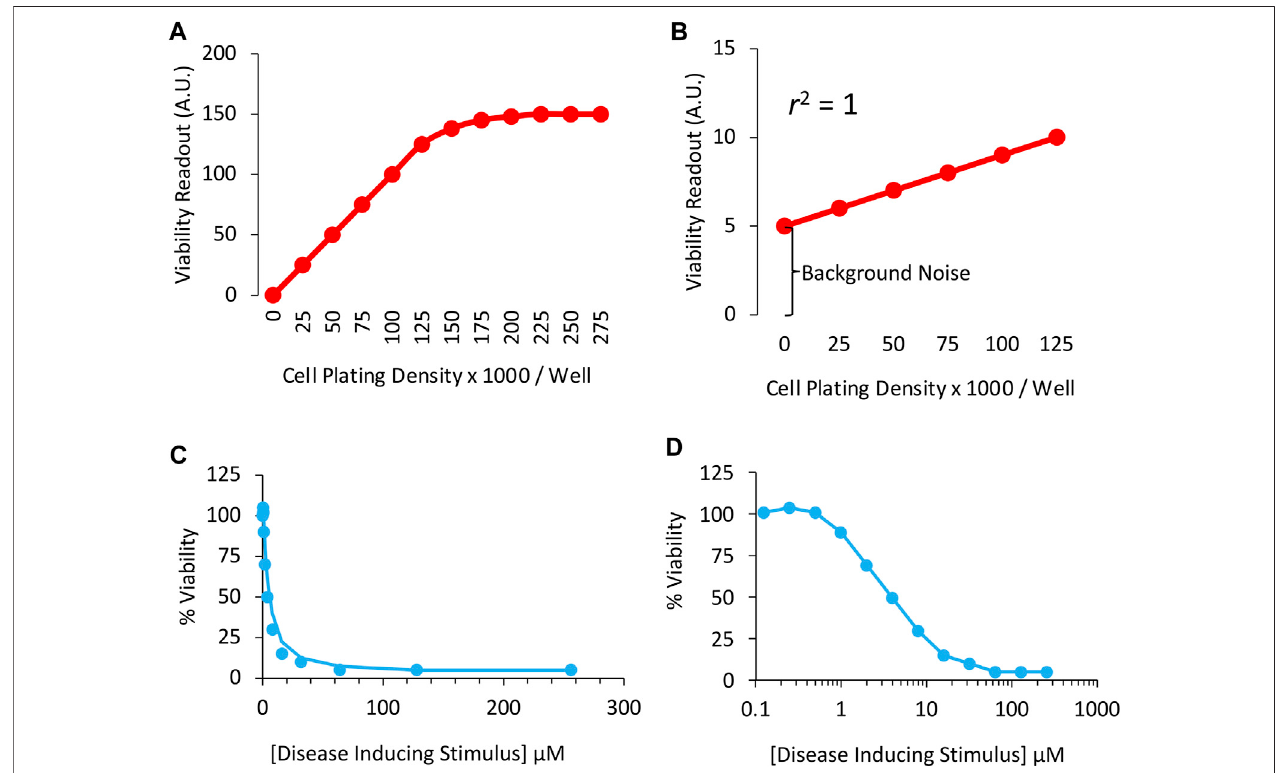
FIGURE 1 | Sensitivity of the in vitro viability assay in cultured cells: (A) Correlation between cell culture plating densities ( X axis) and cellular viability measurements ( Y axis). Note themeasurement plateau at plating densities > 125,000 cells per well. The sensitivity ofthe assay is inadequate in this range and, therefore, the student will fail to observe any effects of treatment on viability at high cell densities. (B) A perfect correlation between plating densities and viability measurements is obtained, but background noise accounts for too much of the positive signal plotted on the Y axis. High background noise masks the size of differences across groups. (C) Concentration-responseorconcentration-effectcurveforthedisease-inducingstimulusinacellculture-basedviabilityassay,plottedonalinearscale. (D) Concentration vs. effect curve for the disease-inducing stimulus in a cell culture-based viability assay, plotted on a logarithmic scale. The LC 50 (or IC 50 ) in this example is 4 μ M of the toxicity-inducing stimulus. Two-fold (rather than ten-fold) changes in concentration are employed to promote greater con fi dence in the LC 50 measurements.